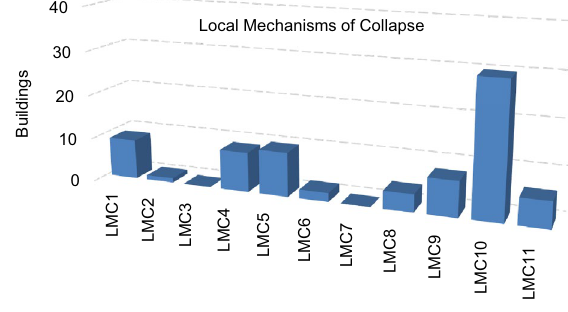
Fig. 9 No. of assigned buildings to each identified local mecha- nisms of collapse